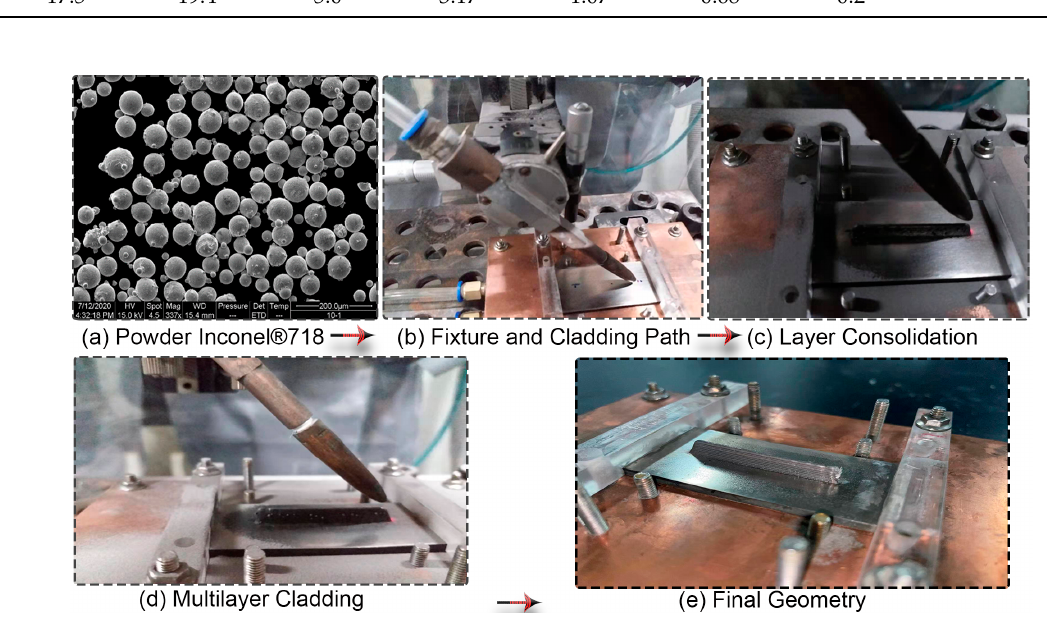
Figure 2. Experimental process sequence from powder to final geometry of 10 layers.